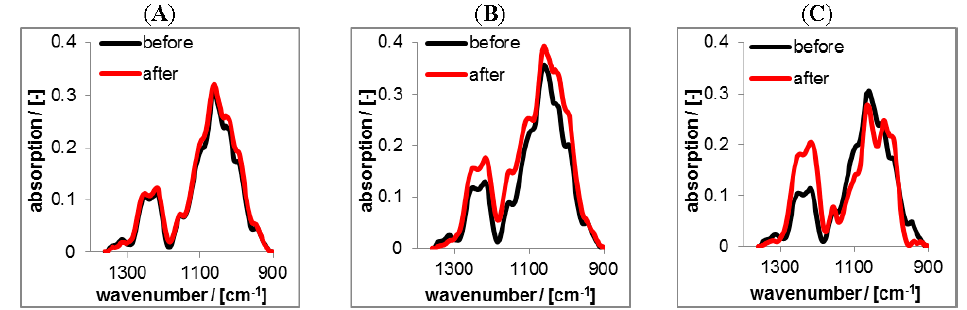
Figure 10. ATR-FTIR spectra of solution casted RIS loaded PEC 0.9 coatings prepared at pH = 10 (after centrifugation procedure) before (black) and after (red) rinsing (2 days) with tris(hydroxymethyl)- aminomethane (TRIS) at pH = 10 ( A ); HEPES at pH = 7 ( B ) and CIT at pH = 4 ( C ).